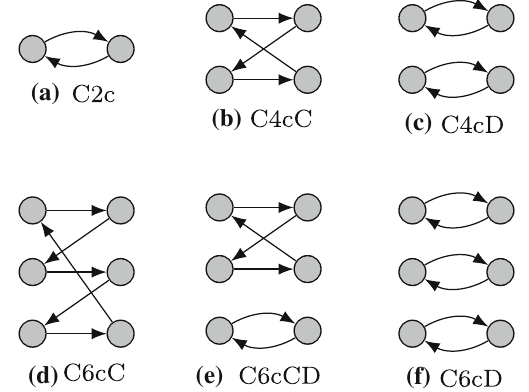
Fig. 4 Quark contraction diagrams for the one-, two- and three- π + correlation functions needed in this